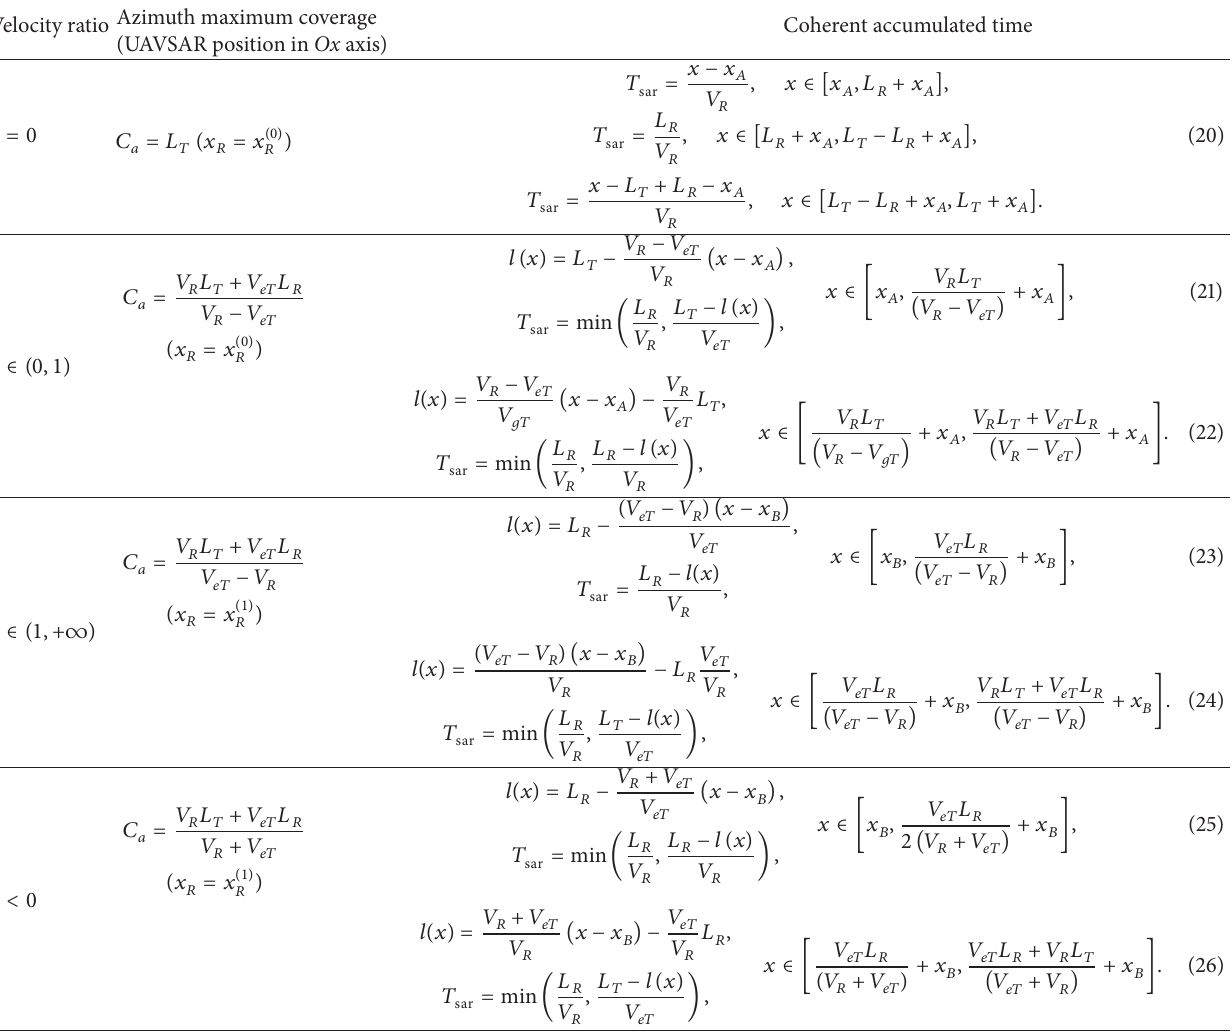
Table 4: Space-time analysis of GEO-UAV